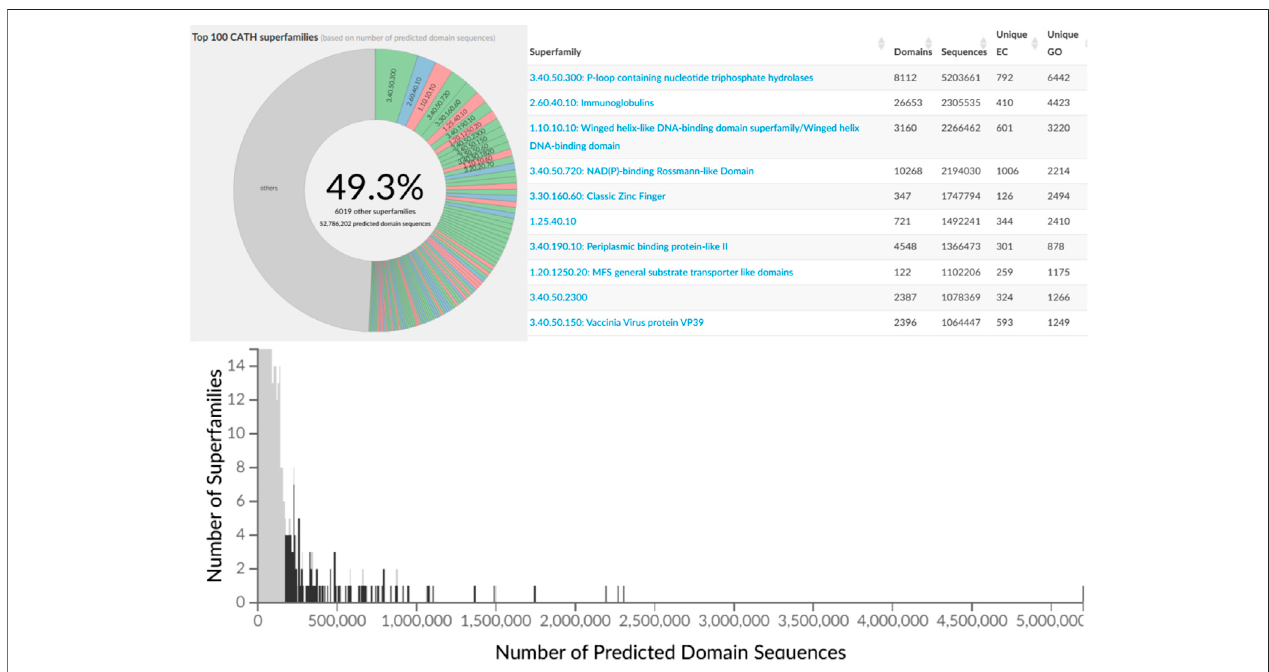
FIGURE7| Top100mostpopulatedCATHSuperFamilies(CATHv4.3)withadditionaldetailsregardingsequencecountsanduniqueECandGOtermsforthetop 10 most populated